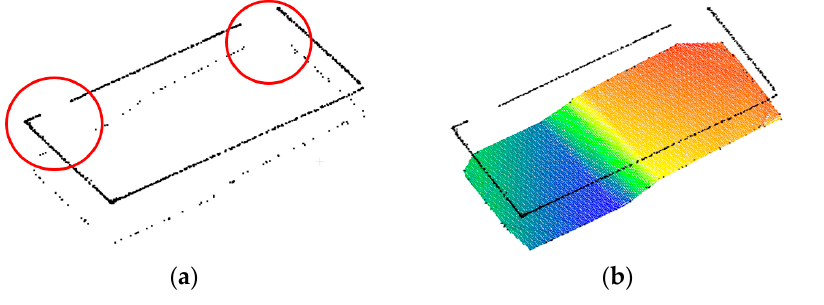
Figure 8. ( a ) Point cloud after synchronisation and correction operations; ( b ) interpolated pool bottom; ( c ) 3D model of the pool surveyed using traditional methods.